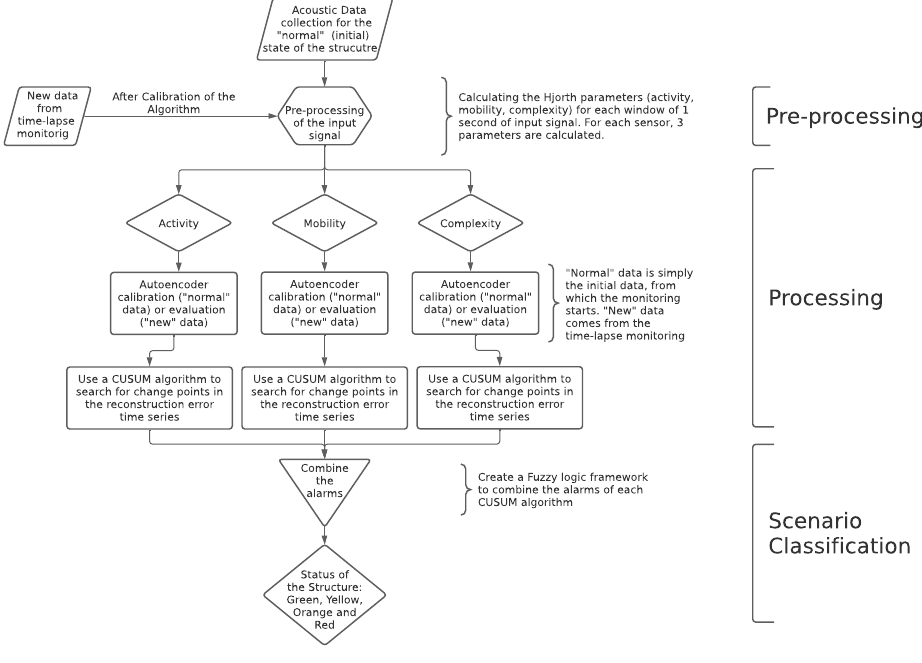
Figure 1. Methodological